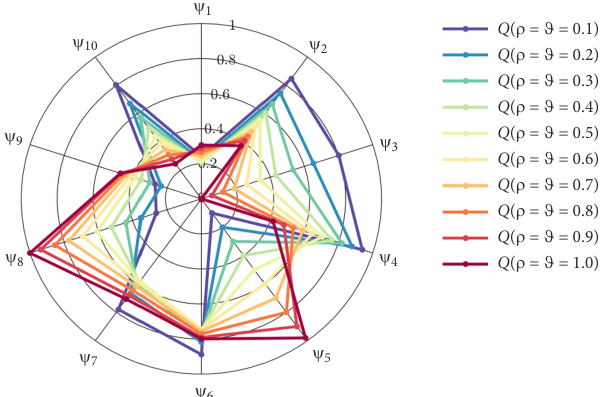
Figure 4. The variation trend of Q i with J ∈ [0,1] and r ∈